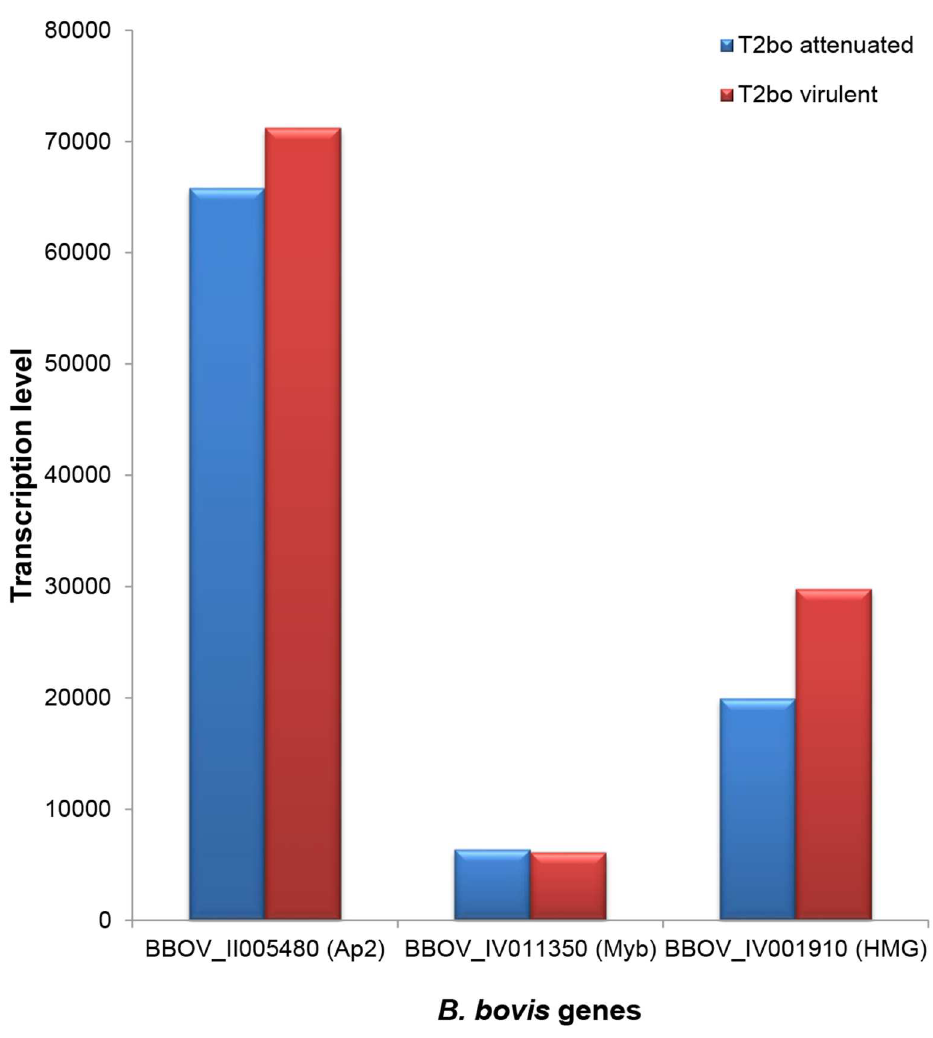
Fig 8. Comparison among the highest transcribed genes of the AP2, Myb , and HMG genes of B . bovis . The Ap2 gene BBOV_II005480 shows the highest transcription levels compared to the highest transcribed genes of the Myb and HMG gene groups in B . bovis